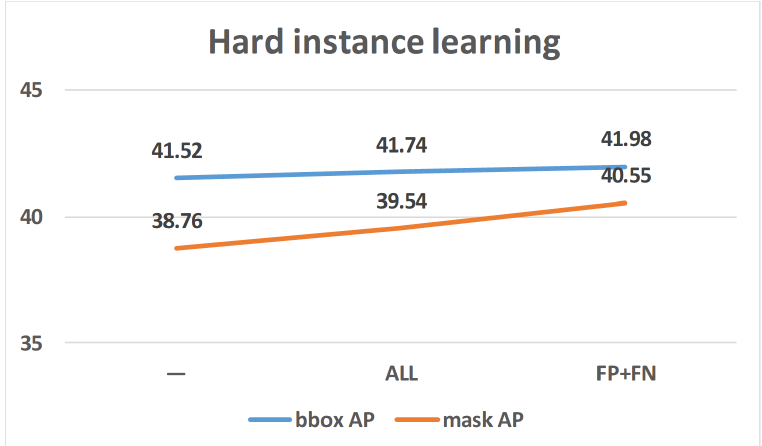
Figure 9. Effects of hard-to-segment instance learning. “–” indicates the results of Mask R-CNN without using the hard-to-segment instance learning method.